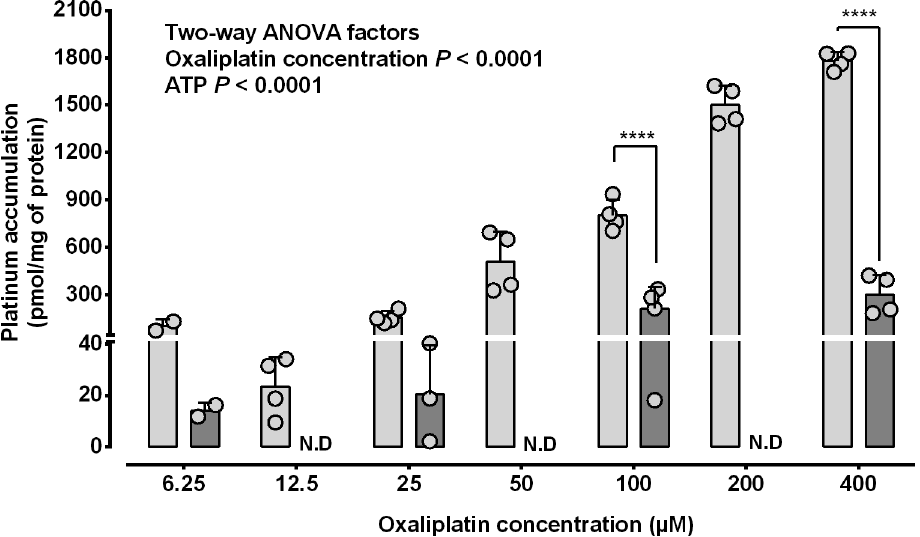
Fig 3. MRP2-mediated membrane vesicle accumulation of oxaliplatin-derived platinum: dependence upon oxaliplatin exposure concentration and ATP. MRP2-expressing membrane vesicles were incubated with oxaliplatin (6.25 to 400 μ M) with or without ATP (4 mM) for 10 min before measurement of platinum accumulation by ICPMS. The P values shown as numbers are from two-way ANOVA and those shown as **** ( P < 0.0001) are from Tukey ’ s multiple comparison post-tests following two-way ANOVA. The bars represent means and standard deviations from individual values (open symbols) pooled from two independent experiments. Light grey bars, with ATP. Dark grey bars, without